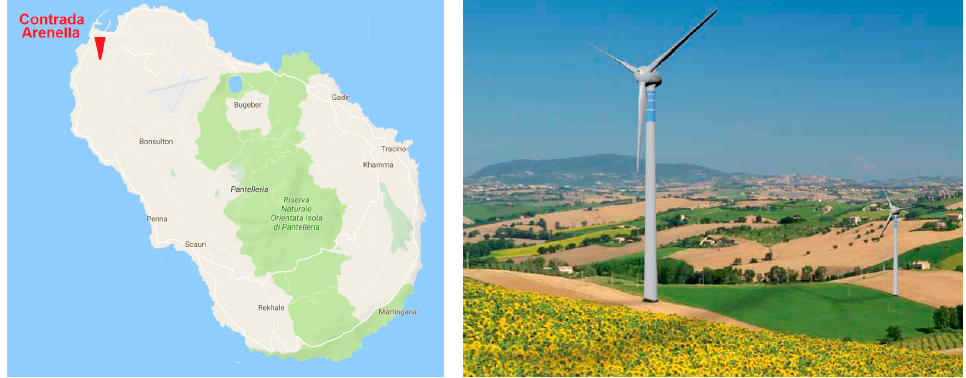
Figure 13. Location on “Contrada Arenella” and a rendering view of a wind farm.